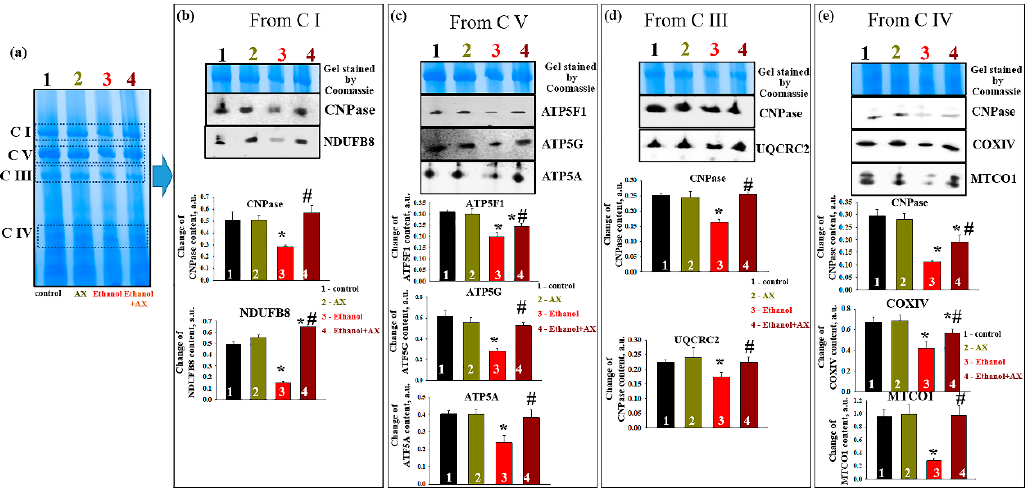
Figure 6. The effect of AX and Ethanol on the change of proteins associated with respiratory chain complexes and F o F 1 -ATP synthase. The native RLM were separated to the first dimension by BNE. Bands containing the corresponding complexes were cut out from the gel and applied to the lanes of 12.5% PAAG and separated in the second dimension. The proteins were transferred from the gel to the nitrocellulose membrane. The membrane was stained with the corresponding antibodies. ( a )—the separation of mitochondrial samples to the first dimension by BNE; ( b )—the proteins associated with complex I. Upper part: the gel stained with Coomassie, the Western blot stained with CNPase and NDUFB8; low part: the changes of proteins content (absolute units). ( c )—the proteins associated with complex V. Upper part: the gel stained with Coomassie, the Western blot stained with ATP5F1, ATP5G, and ATP5A; low part: the changes of proteins content (absolute units). ( d )—the proteins associated with complex III. Upper part: the gel stained with Coomassie, the Western blot stained with CNPase and UQCRC2; low part: the changes of protein content (absolute units). ( e )—the proteins associated with complex IV. Upper part: the gel stained with Coomassie, the Western blot stained with CNPase, COXIV, and MTCO1. The data are presented as mean ± SD of three independent experiments. * p < 0.05 indicates a significant difference in the protein levels compared to the control (Group 1). # p < 0.05 compared with the corresponding value in the protein levels in RLM from ethanol-administrated rats (Group 3). Statistical significance was assessed using